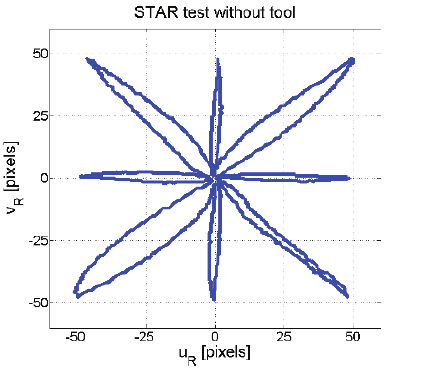
Figure 21. End-e(cid:636)ector visual trajectory in the image plane during the STAR test performed without the tool.